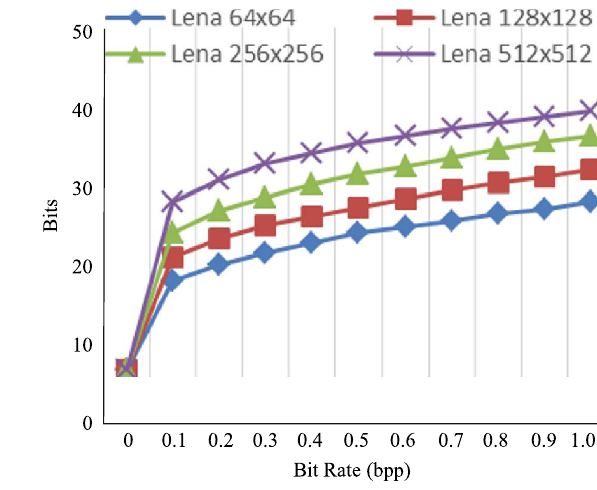
FIG. 6. PSNR PERFORMANCE FOR BOTH CASCADING AT GIVEN